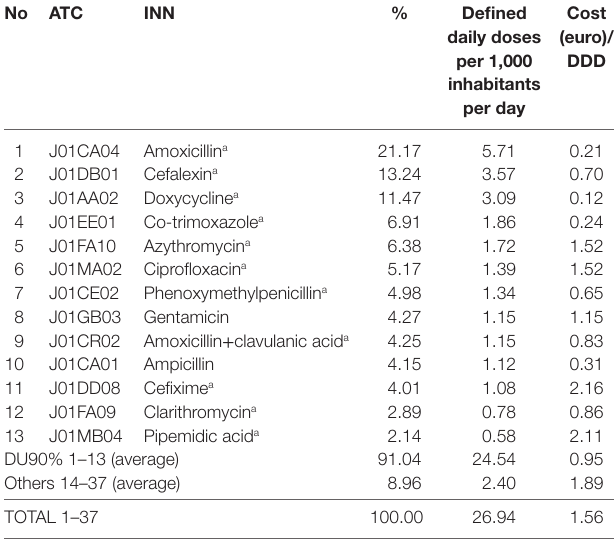
TaBle 8 | Antibiotics for systemic use (J01) within DU90% segment expressed in the number of DDDs/TID, and the cost per defined daily dose (DDD) in Euros within and beyond DU90% segment in south backa district